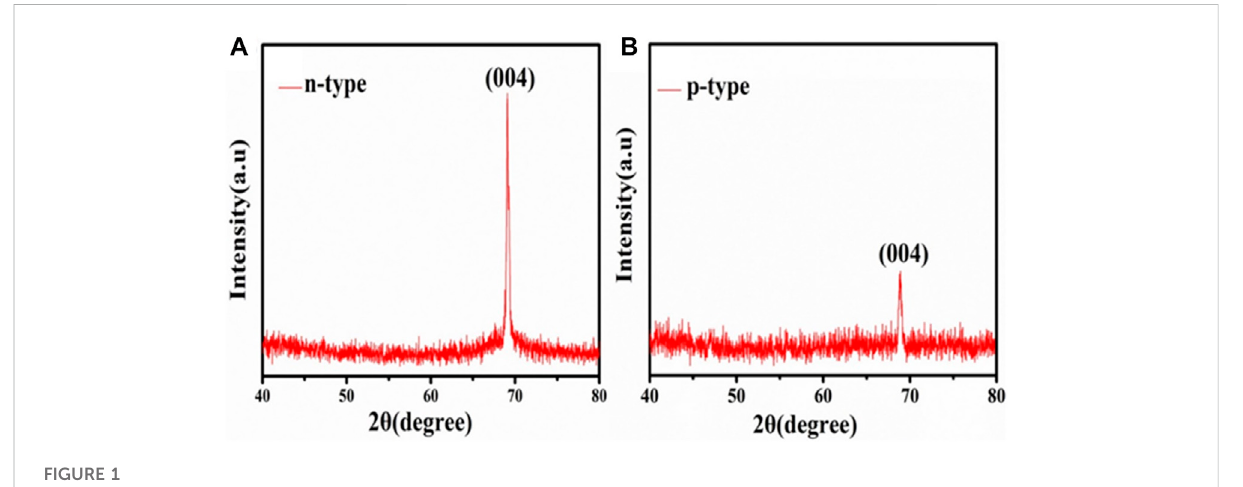
FIGURE 1 XRD of Si NWs (A) n 40 and (B) p 40